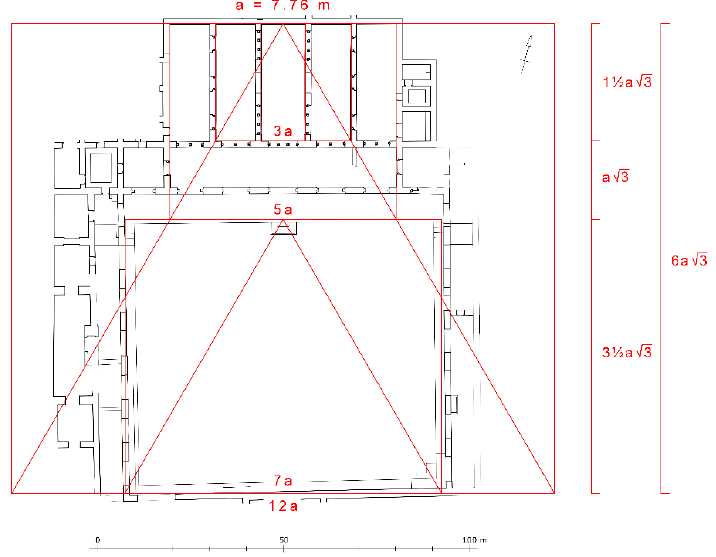
Figure 3. Design scheme of the D ā r al- Ǧ und, based on the use of equilateral triangles. Drawing by Felix Arnold, based on the plan by Ana Zamorano.